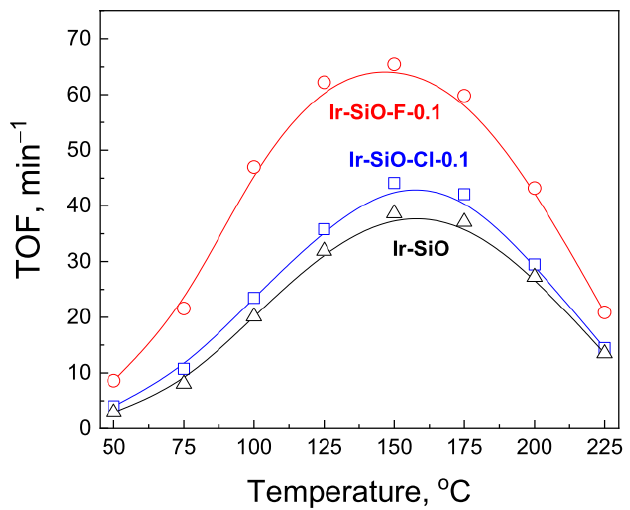
Figure 9. Effect of support on the turnover frequencies of hydrogenation of TL as a function of reaction temperature.